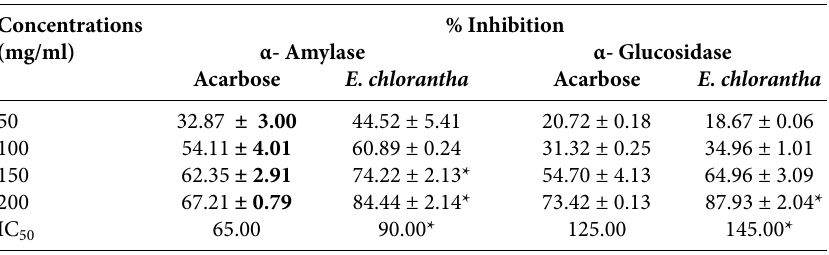
Table 5. Inhibitory potential of E. chlorantha ethanolic extract on the activity of α amylase and α glucosidase (n = 3, mean ± SD).